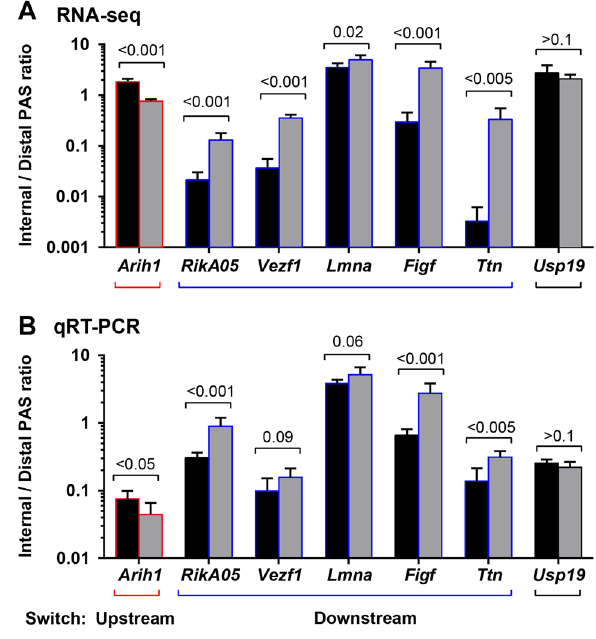
Fig. 5 PAS switch between regions in quadriceps and tibialis anterior muscles. a Bar chart shows the ratio between distal to internal PAS obtained from read counts from polyA-sequencing in quadriceps muscle. Expression values were obtained after TMM normalization. Averages and SD are from six mice. b Bar chart shows the ratio between distal to internal PAS obtained from qRT-PCR analysis in tibialis anterior muscle. Averages and SD are from six mice. p -values for the differences between A17.1 and WT tibialis anterior muscles were assessed with the Student ’ s t -test. Red outlines depict a downstream switch, and blue outlines an upstream switch